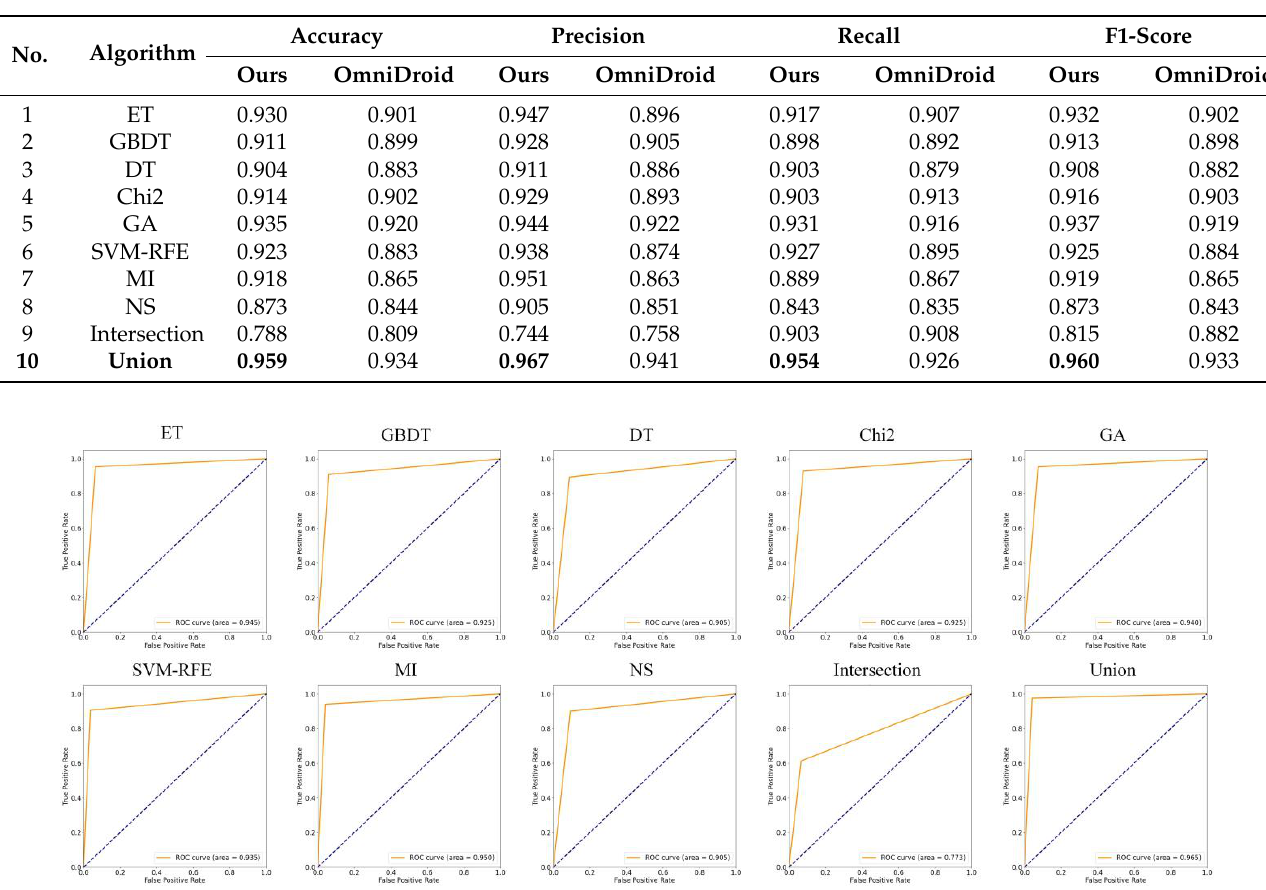
Figure 6. Confusion matrix of different feature selection methods on our dataset. Figure 7. Feature selection results comparison on OmniDroid dataset.